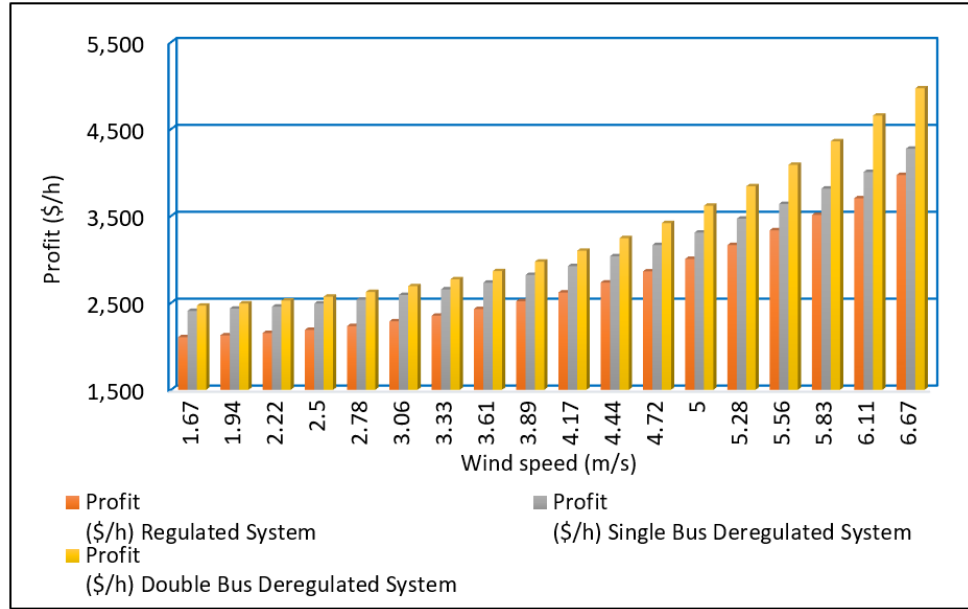
Figure 6. Profit for a regulated and deregulated system after the placement of a wind generator.